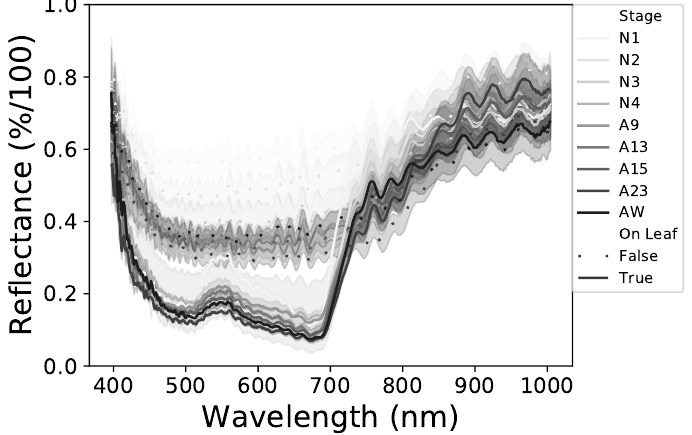
( c ) White–dark normalized spectra of R. padi LR01 (black aphids).